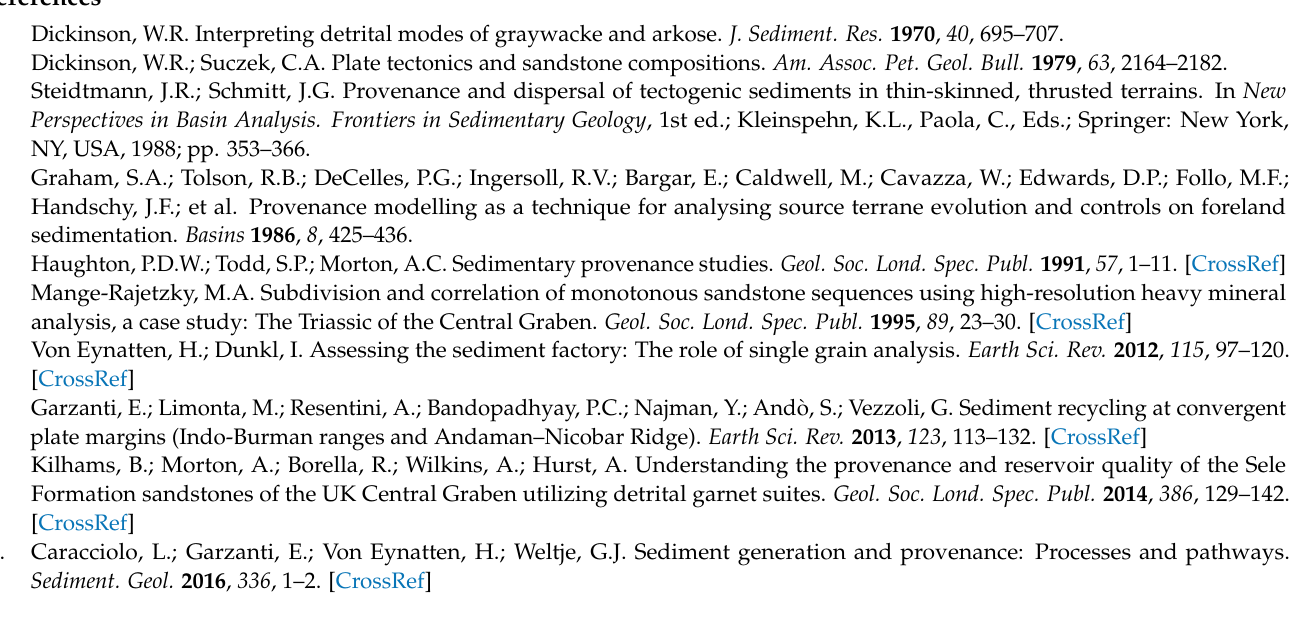
grains, Figure S3: Compositional plots for all the analyzed samples, Figure S4: Images of the appearance of each of the described petrofacies in the conglomerate-sized deposits, Figure S5: Biplot of the two sub-groups of the MLC petrofacies, Figure S6: Heavy-mineral percentage pie charts for all the analyzed samples in a general stratigraphic cross-section sketch, Figure S7. Heavy- mineral percentage pie charts for all the analyzed samples in a general stratigraphic cross-section sketch. Table S1: Sandstone compositional data (point counting analyses), Table S2: Heavy-mineral compositional data (point counting analyses), Sample coordinates: Geographic coordinates of the studied